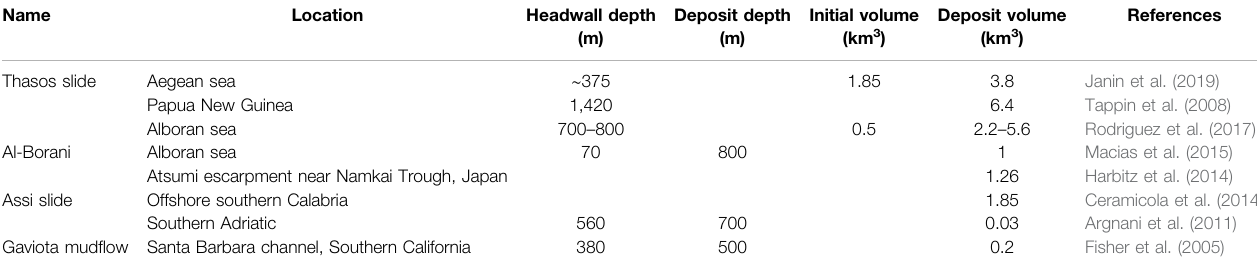
TABLE 1 | List of submarine landslides with volumes comparable to the NTS and the SGBS whose tsunamigenic potential has been explored in literature.